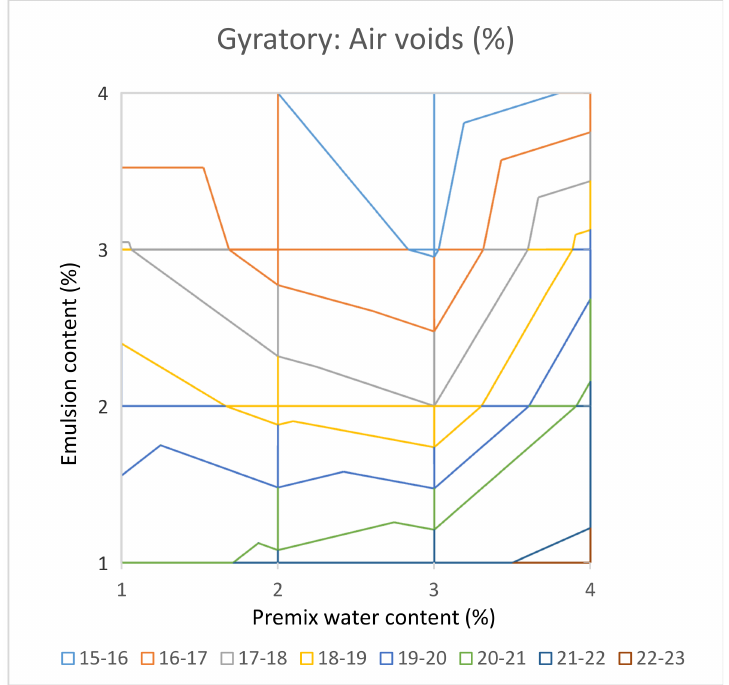
Figure 11. Air voids content for mixtures compacted with the gyratory